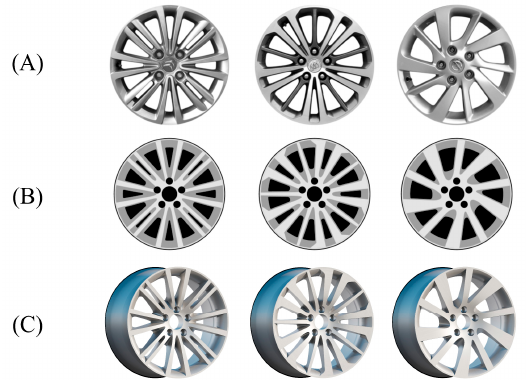
Figure 14. Results of the reconstruction of wheel hub shape. ( A ) Original sample. ( B ) Generated 2D shapes. ( C ) Constructed 3D models.